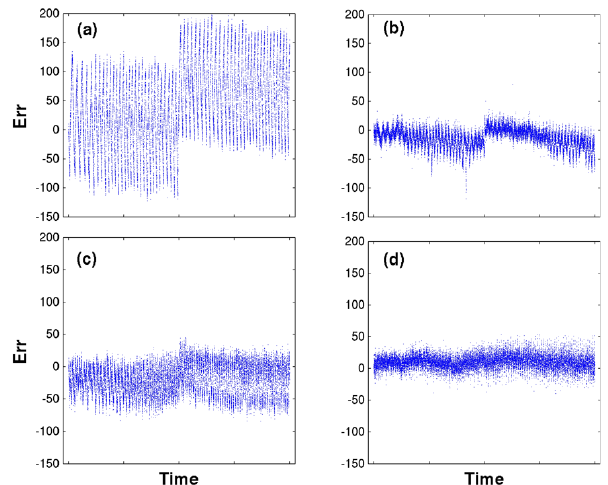
Fig. 11. Time series of errors [ Pa ] from Fig. 10: (a) and (b) are before and after correction, respectively, for attack changes; (c) and (d) before and after correction, respectively, for sideslip changes.